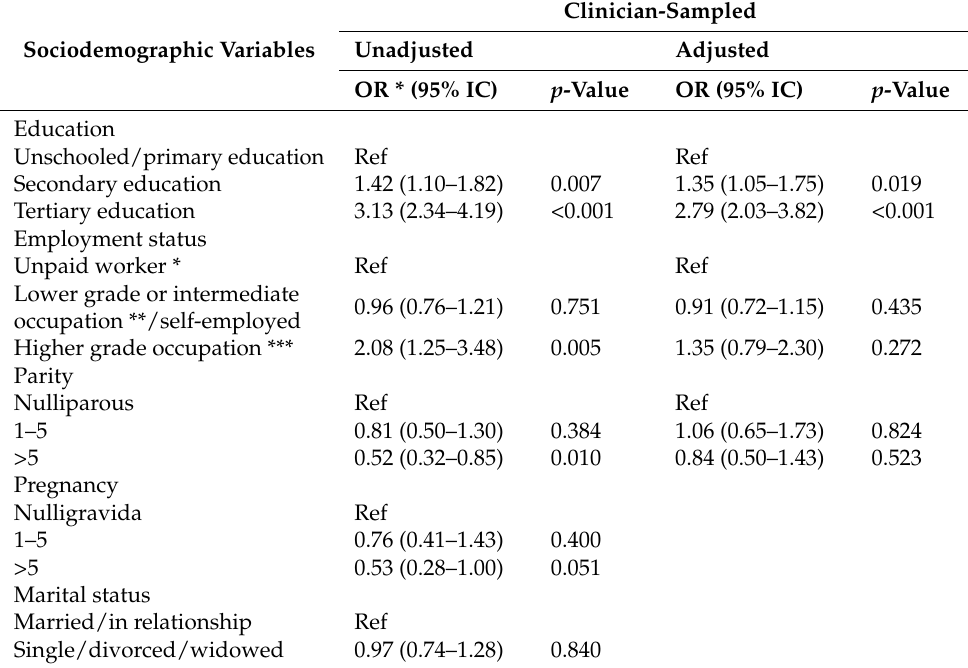
Table 3. Association of sociodemographic factors with preference for clinician-sampled.